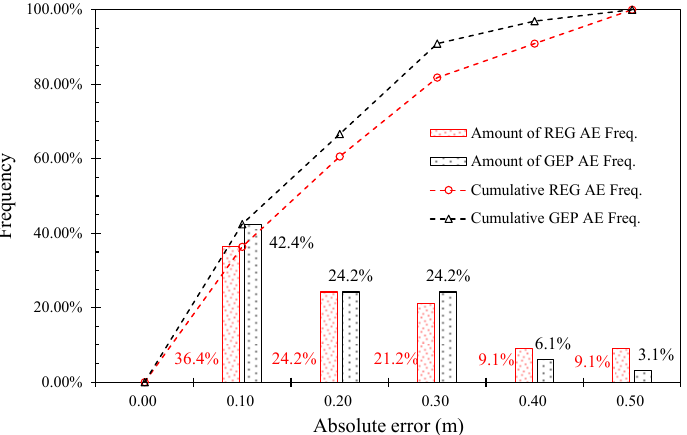
Figure 13. The absolute error (AE) of modeled and observed water depth of the testing dataset.